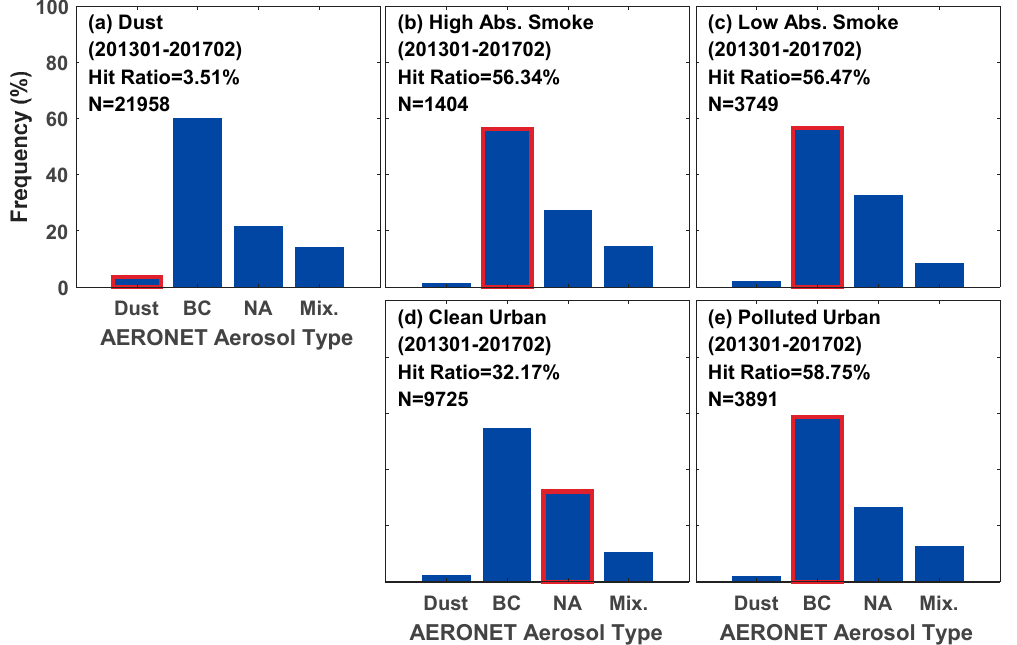
Figure 5. Corresponding AERONET aerosol types for each VIIRS aerosol type. The red box indicates the AERONET aerosol type that is consistent with that of VIIRS. The y -axis denotes the frequency of different types of AERONET at a given VIIRS aerosol type: ( a ) Dust; ( b ) High Absorption Smoke; ( c ) Low Absorption Smoke; ( d ) Clean Urban; and ( e ) Polluted Urban. The comparison between VIIRS EDR AODs and ground AERONET observations (N =